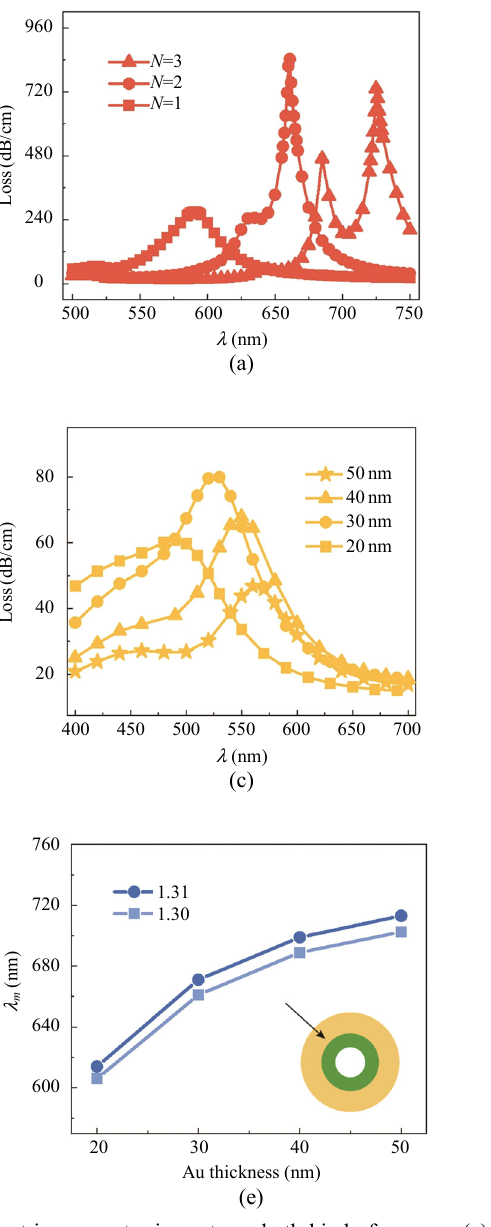
Fig. 3 Geometric parameter impacts on both kind of sensors: (a) and (b) loss spectra for the QDs/Au sensors with different layer numbers of QDs or thickness of Au; (c) loss spectra for the Au sensors with different thicknesses of Au; (d), (e), and (f)) corresponding peak positions to (a), (b), and (c) for n a = 1.30 and 1.31, respectively. The insets indicate the part for the thickness